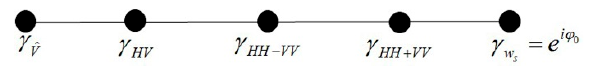
Figure 5. Schematic representation of the relative location of the coherence values in the Pauli states along the coherence line [7].